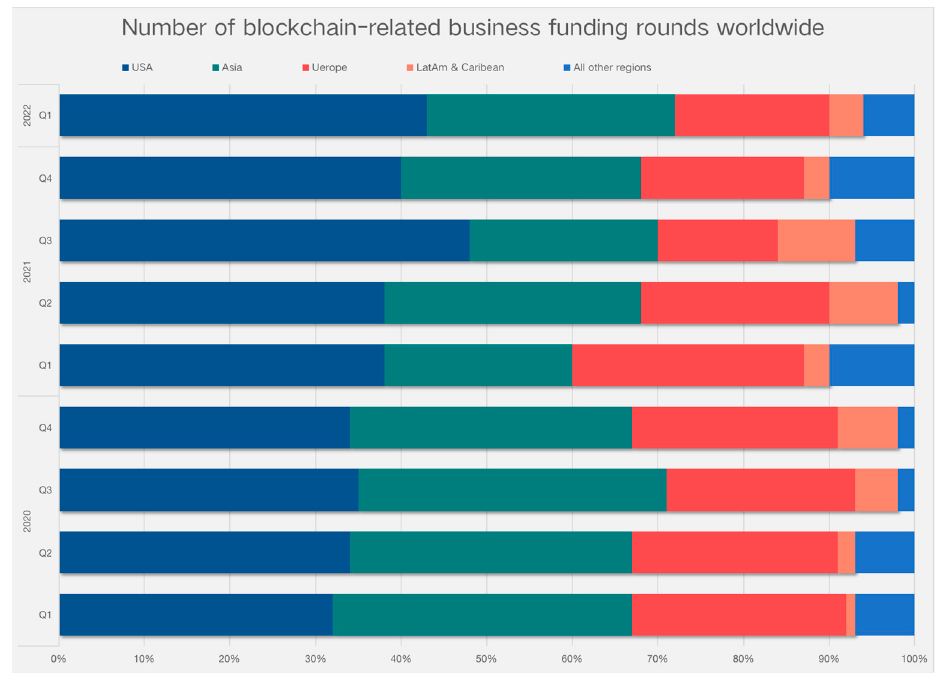
Figure 3. Number of blockchain-related business funding rounds worldwide.